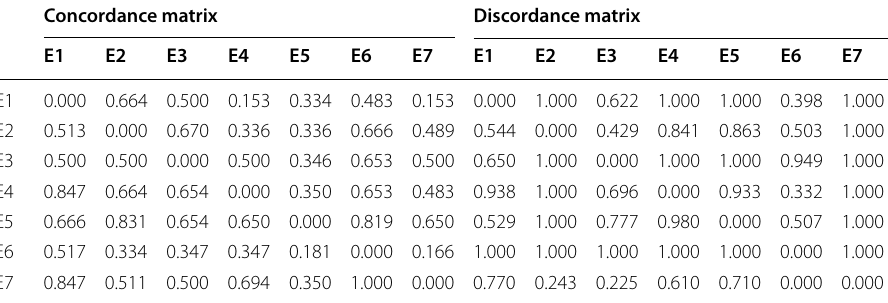
Table 23 Concordance and discordance interval matrixes Concordance matrix Discordance